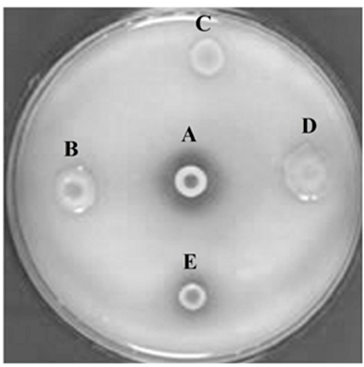
Figure 1. Screening for phytasic activity in metagenomic library using Na-IHP as substrate. A: positive control ( Bacillus subtilis ); B, C and D: clones with negative phytase activity; E: clone with positive phytase